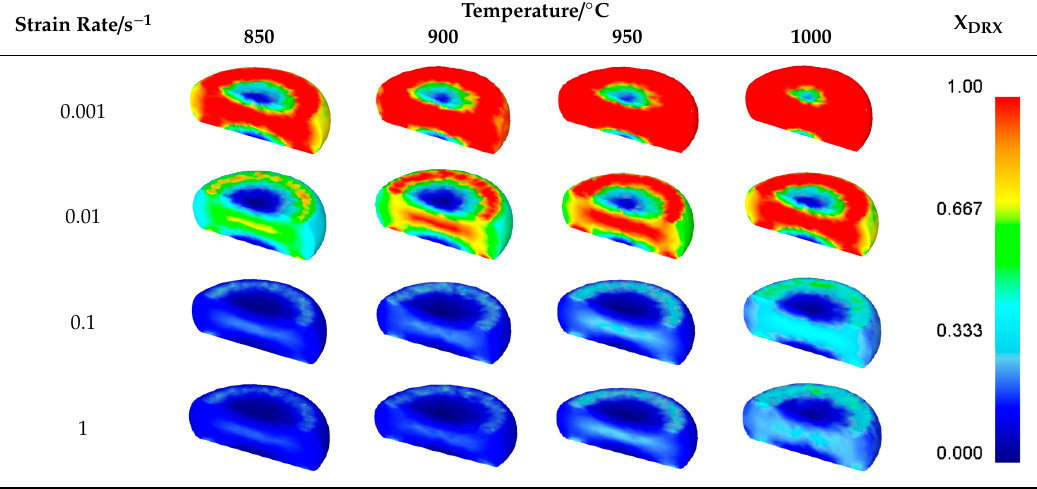
Table 4. The distribution in the DRX X by FEM for TB8 titanium alloy deformed at a strain of 0.8.